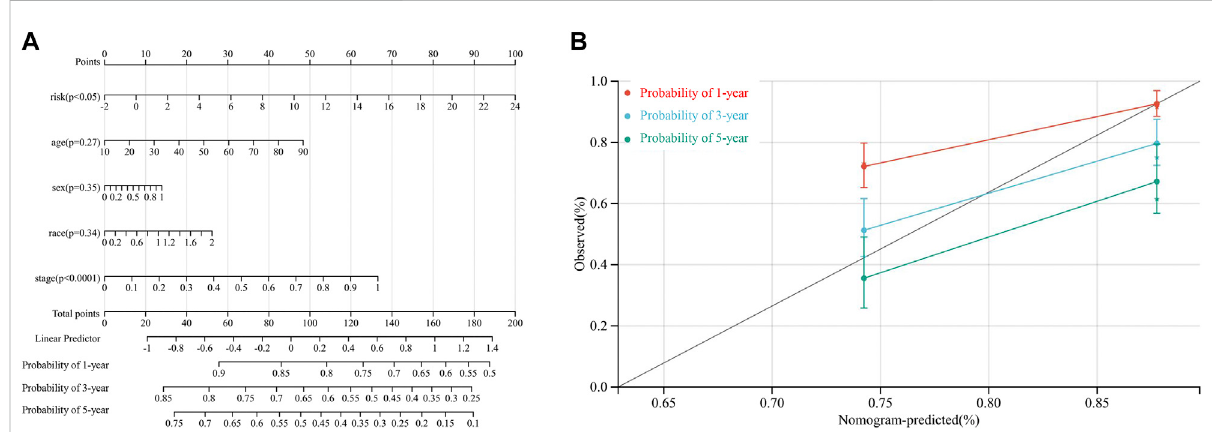
FIGURE 7 . Nomogram to predict the probability of a 1-year, a 3-year, and a 5-year OS in patients with HCC based on the TCGA-LIHC dataset. (A) the nomogram was constructed based on fi ve clinical factors, and results suggested that the risk score and TNM stage signi fi cantly affected the OS of patients with HCC. For the factor sex, 0 represents male and 1 represents female; for the factor race, 0 represents the white, 1 represents the Asian, and2representsothers;fortumorstage,0representsstageIorIIwhile1representsstagesIIIandIV (B) .Calibrationplotsofthenomogramfora 1-year, a 3-year, and a 5-year OS.